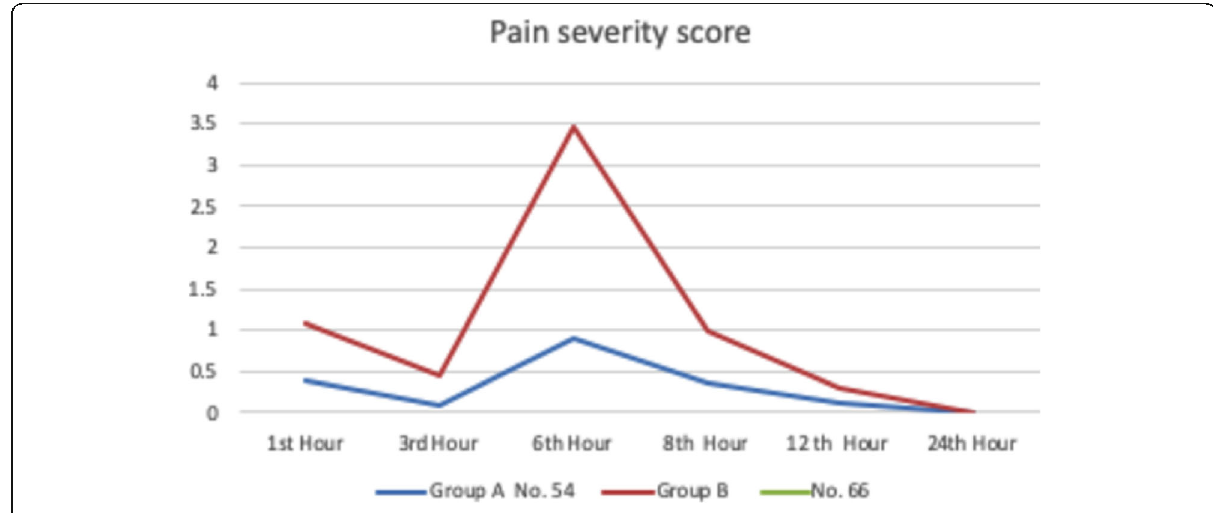
Fig. 1 Changes of pain severity score in study